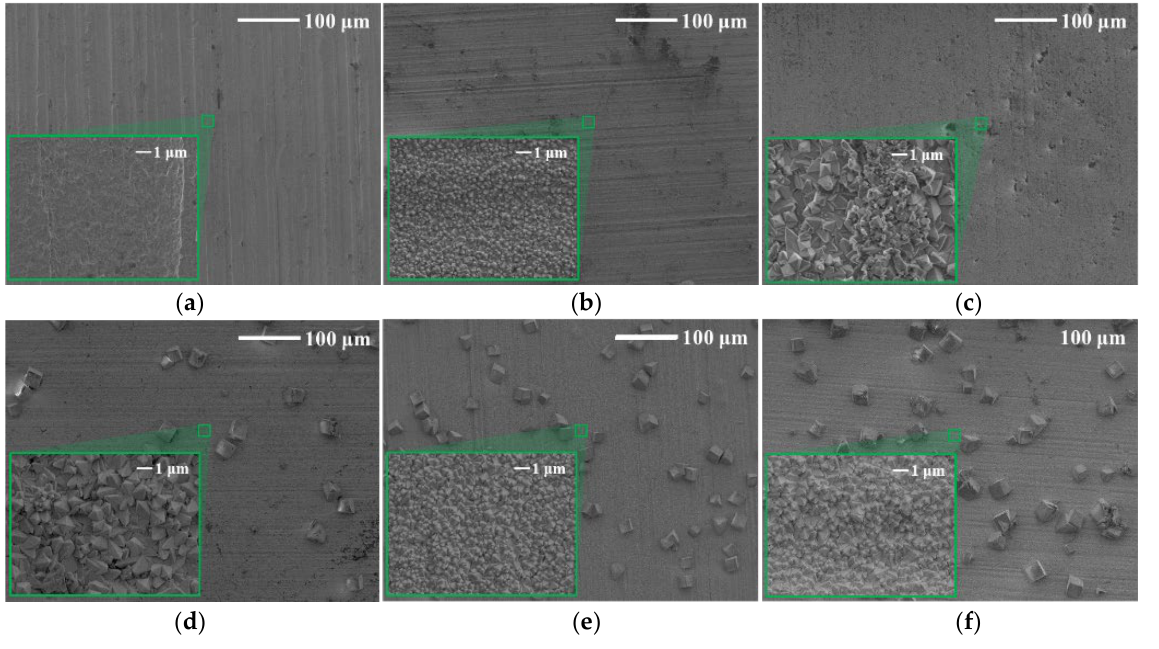
Figure 8. SEM images of ( a ) as-received tungsten and tungsten in tap water for ( b ) 7 days, ( c ) 14 days, ( d ) 21 days, ( e ) 30 days and ( f ) 60 days. (The image in green square is with high magnification).